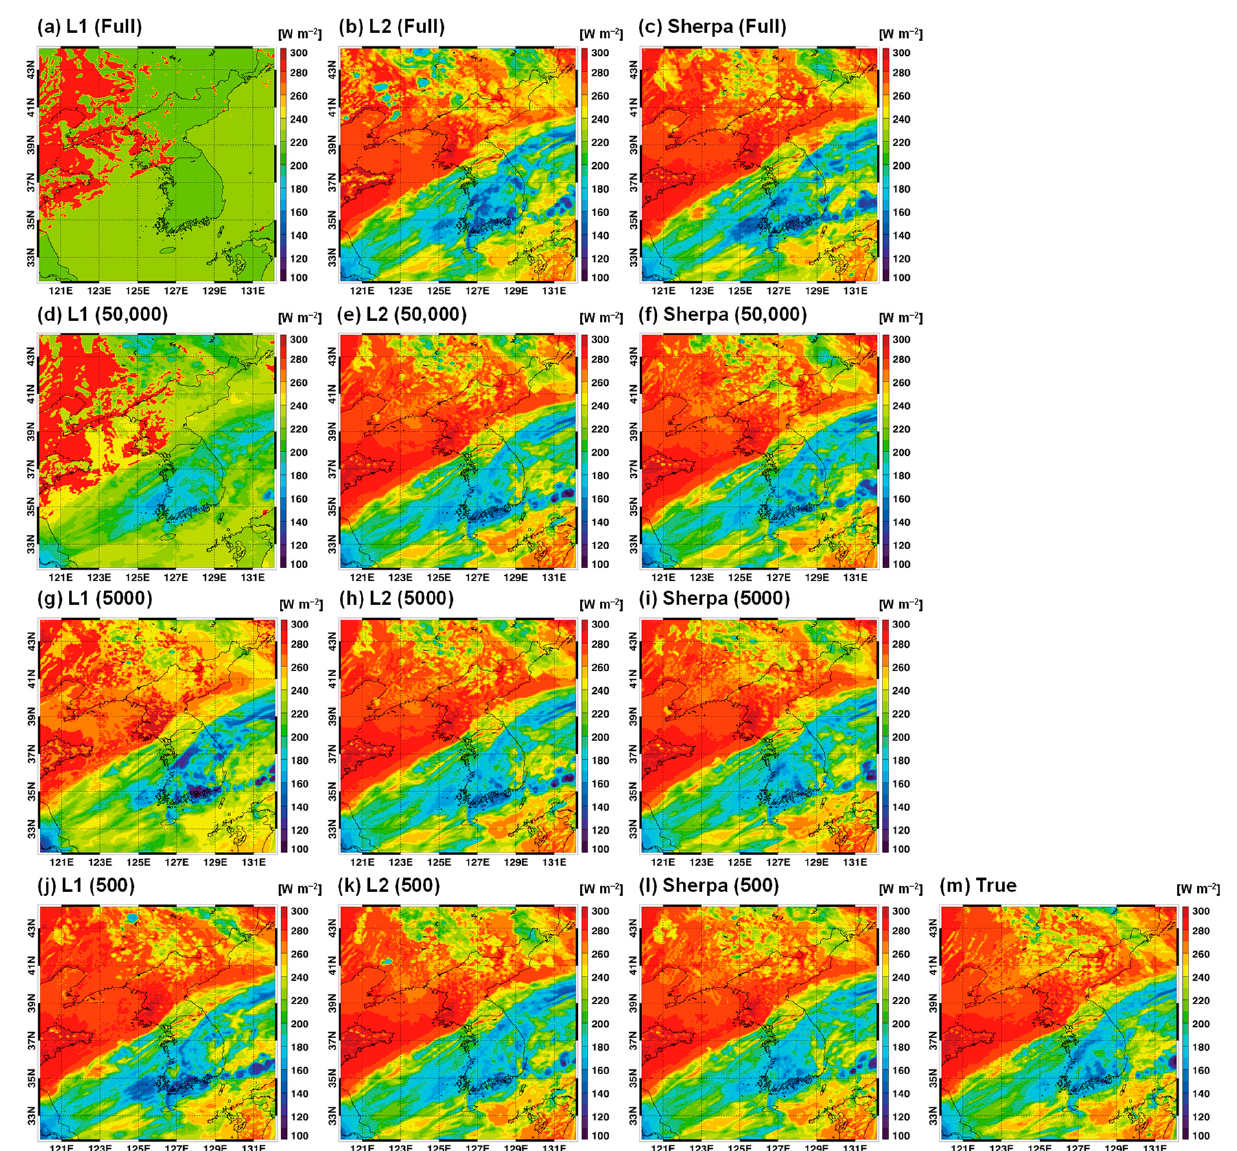
Figure 3. A case example (2020-07-28/03UTC) for the spatial distributions of ( a – i ) outgoing LW radiation (OLR) simulated from radiation emulators trained with different batch sizes and learning rates ( j – l : L1, L2, and Sherpa). This case was integrated by 156 h forecasts initialized from 2020-07-21/15UTC. The true value with the use of original radiation parameterization was also given in ( m ).